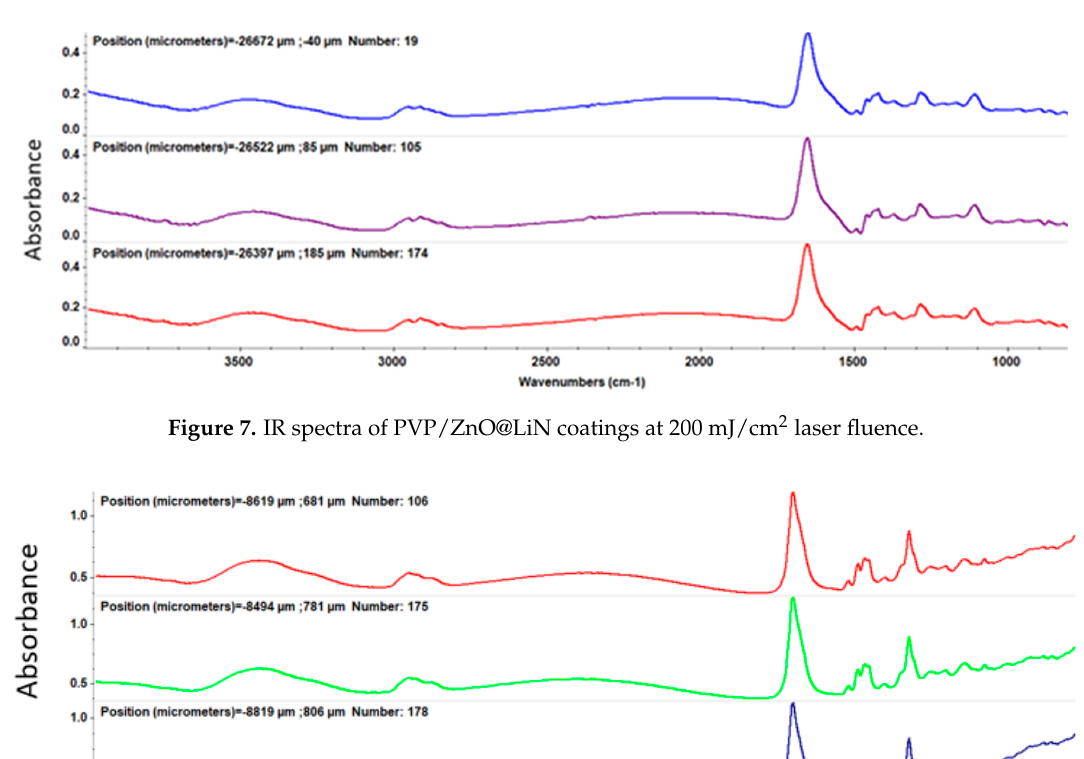
Figure 9. IR spectra of PVP/ZnO@LiN coatings at 400 mJ/cm 2 laser fluence. Through the IRM examination, an optimum sample deposition is found for a laser beam fluence of 300 mJ/cm 2 . Supporting complementary information on the composition and chemical distribu- tion of the coating layer was provided through the IR mapping of the samples. For iden- tifying the optimum sample, the color distribution from the IR maps is considered as ab- sorption intensity increases with the gradual change in color from blue to green, yellow, and red. It can be seen, in the case of the dropcast (Figure 10), that the predominant color is blue, indicating a minimum amount of sample on the substrate or even its absence.